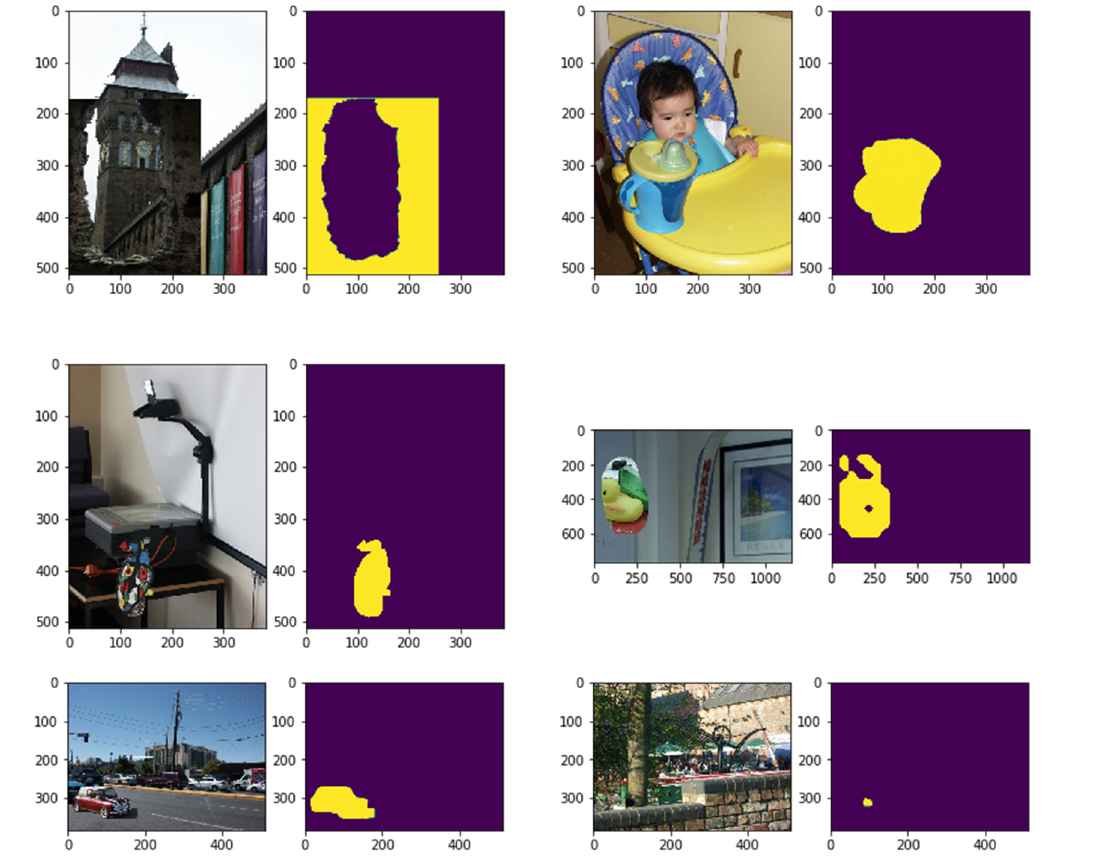
Figure 7. Some examples of forgery-detection. The first and third columns represent the forged images. The second and fourth columns represent the detection results of the proposed model.